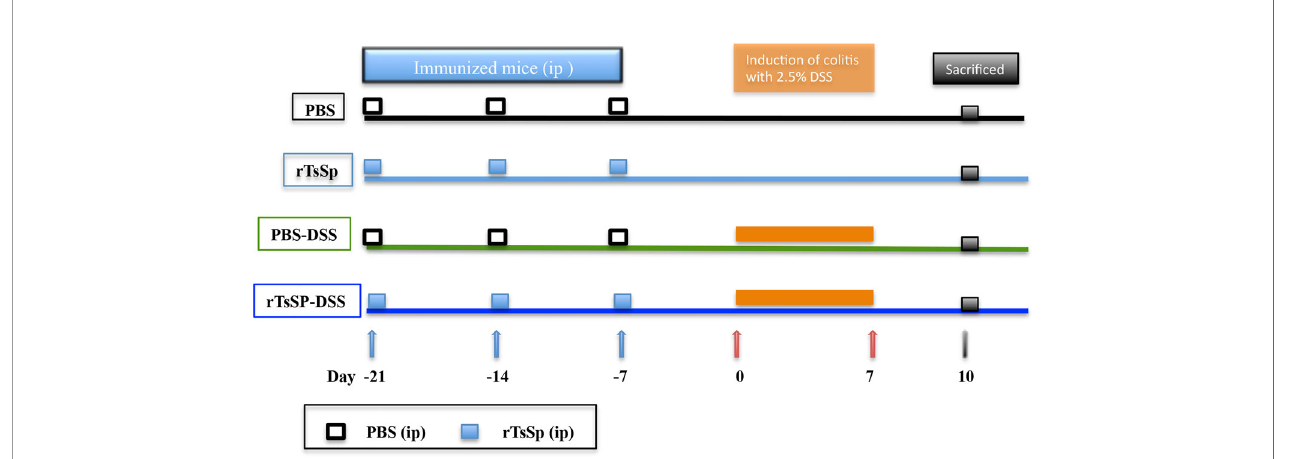
FIGURE 1 | Immunization and DSS-induced colitis